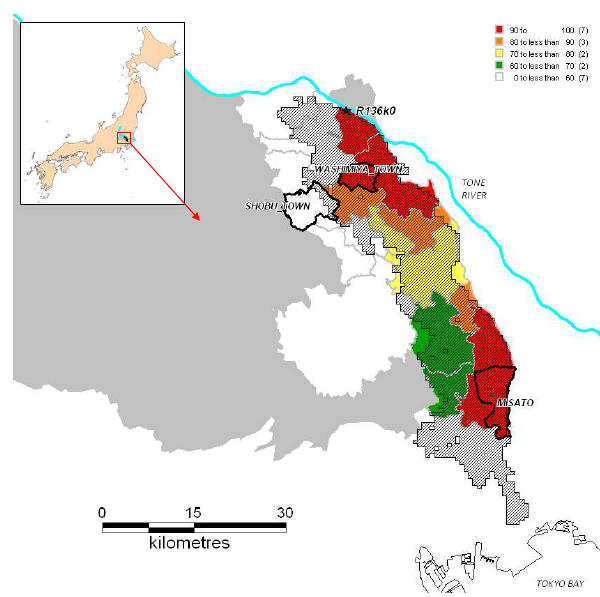
Fig 6: Proportion of low-rise households with water depths greater than 0.45m compared with total Fig. 6. Proportion of low-rise households with water depths greater low-rise households Star: Levee-break point (136km upstream on the right levee), Dark Gray: Other municipalities in than 0.45m compared with total low-rise households Star: Levee- Saitama Shaded polygon: Flood extent of the R136k0 scenario break point (136km upstream on the right levee), Dark Gray: Other (adapted from Tone River Upstream Office, National Statistics Center, National and Regional municipalities in Saitama; Shaded polygon: Flood extent of the Planning Bureau, ESRI Japan Corporation). R136k0 scenario (adapted from Tone River Upstream Office, Na- tional Statistics Center, National and Regional Planning Bureau, ESRI Japan